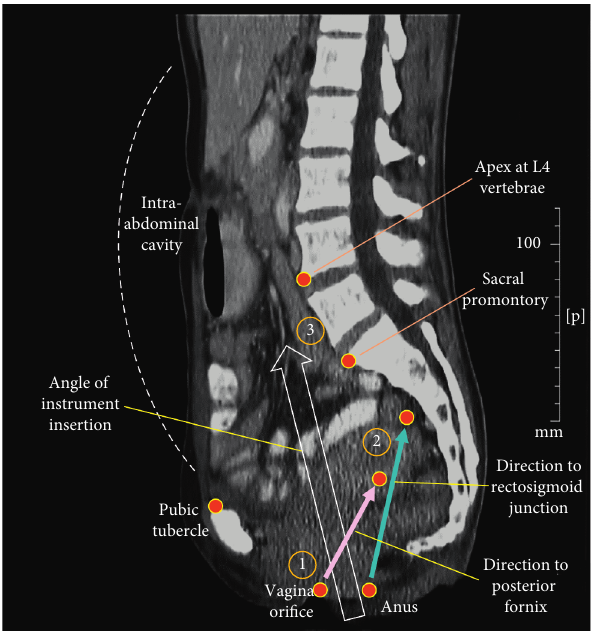
Figure 1: Routes for instrument placement for a transvaginal or transanal NOTES procedure. Location 1 indicates the access route from the vaginal orifice or the anal canal. Location 2 indicates the incision at the posterior fornix or the rectosigmoid junction at which the instruments needs to pass through. Location 3 indicates the spinal segments which the rigid instruments need to